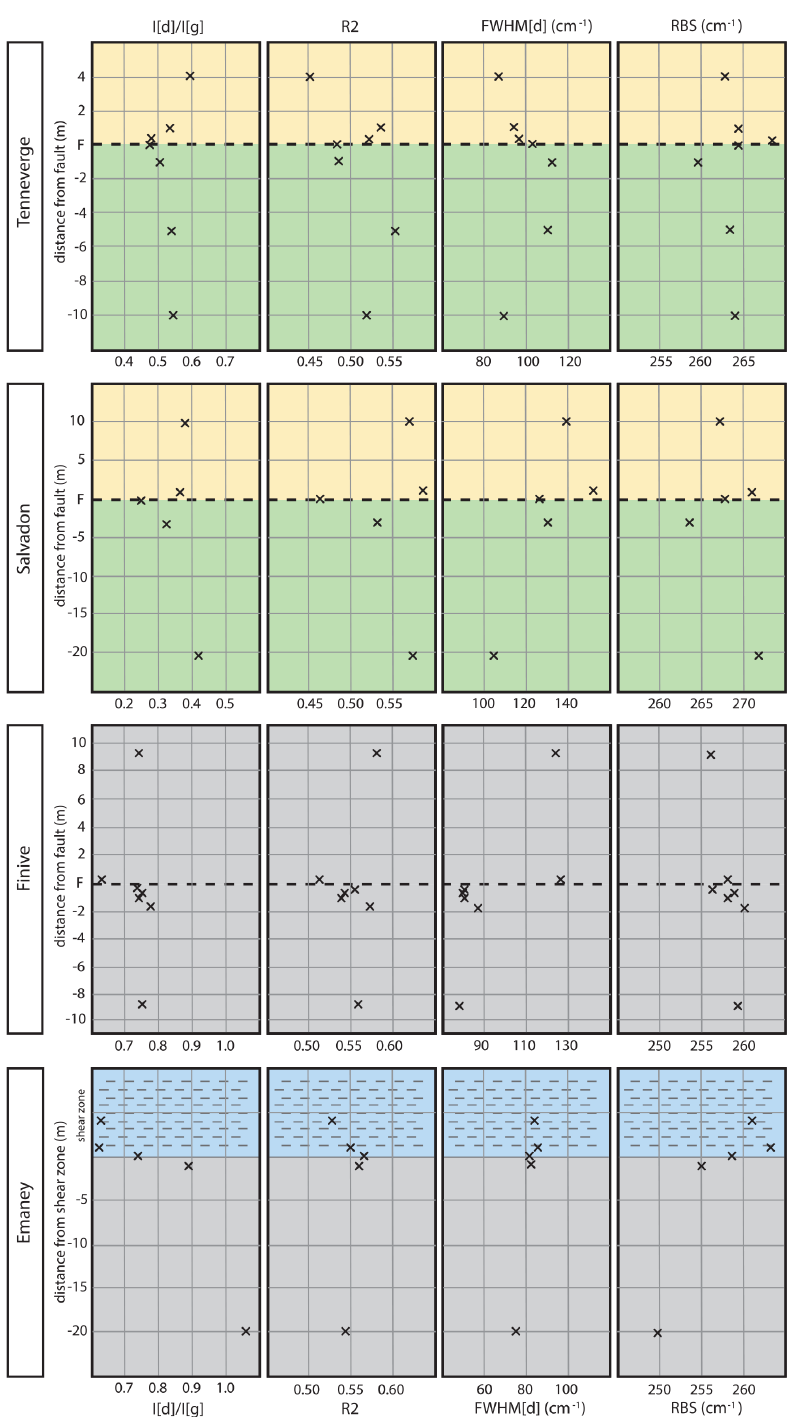
Figure 6. Plots showing the four main Raman parameters in this study ( I D / I G , R 2 , FWHM[d], and RBS) for each of the four “strained localities” (Tenneverge, Salvadon, Finive, and Emaney), with height in metres above (and below) each thrust plane or shear zone labelled on the y axis of each panel. Note that the scale for each plot within a column is the same, but the bounds of the x axis may change. Within each row, lithology is represented by colour, corresponding to the rest of the paper (grey: Bajocian, blue: Oxfordian, yellow: Tithonian, green: Valanginian). Additionally, black dotted lines indicate the presence of a thrust at that height, while grey dashes indicate a shear zone.